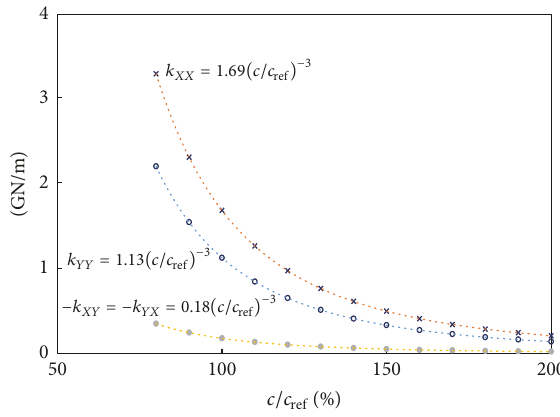
Figure 13: Variation of the upper journal bearing stiffness with the pads clearance (clearance condition